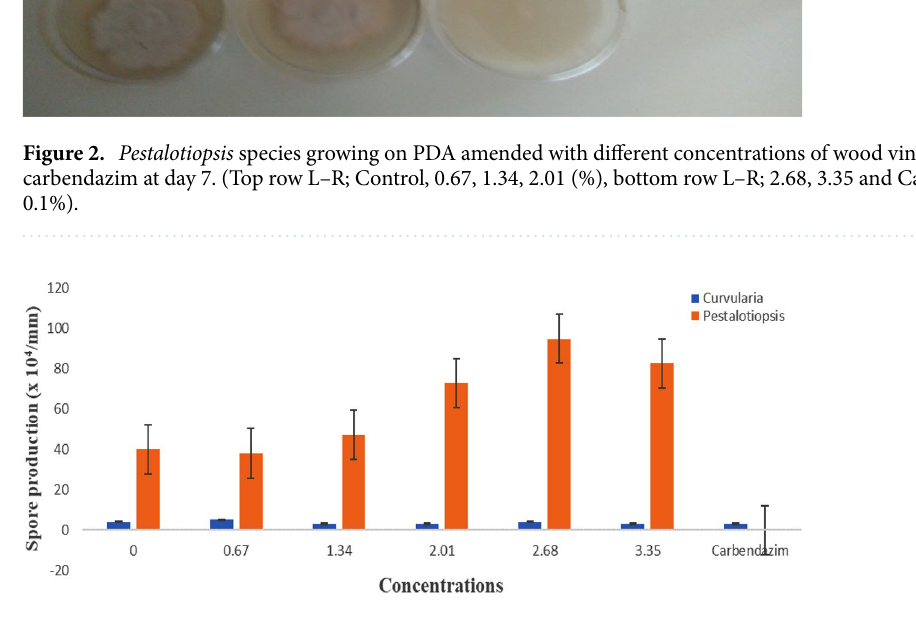
Figure 3. Effect of wood vinegar amended concentrations and carbendazim on spore production of the pathogens.